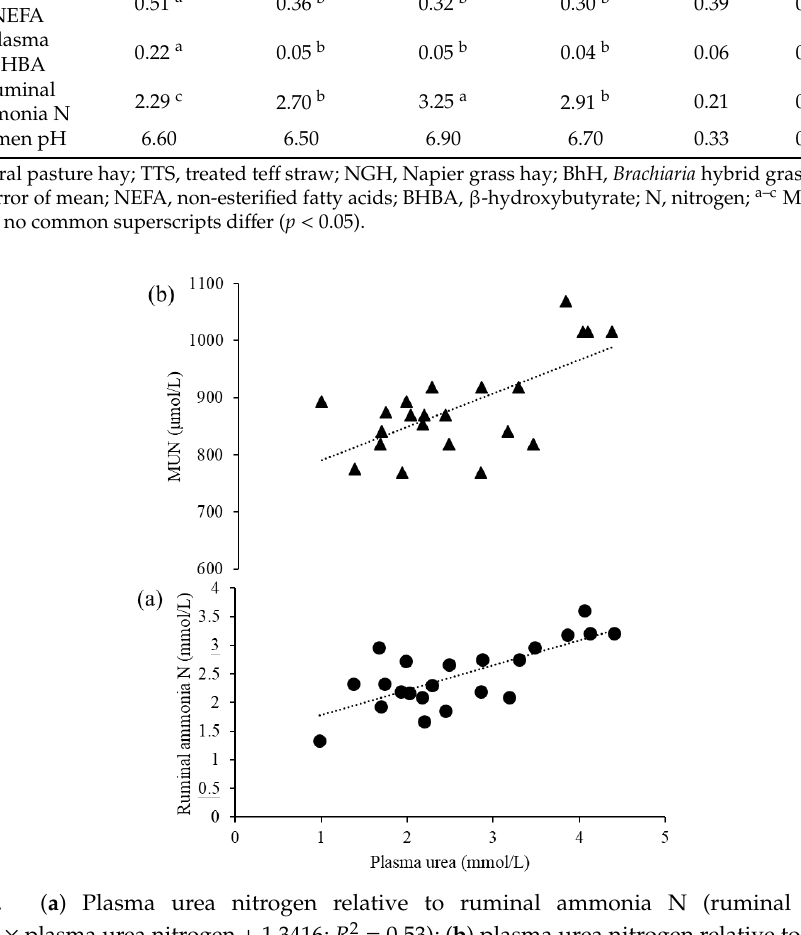
Table 4. Plasma concentrations (mmol / L) of metabolites, and ruminal fermentation characteristics in lactating dairy cows fed natural pasture hay, treated te ff straw, Napier grass hay, and Brachiaria hybrid grass hay. Dietary Treatment